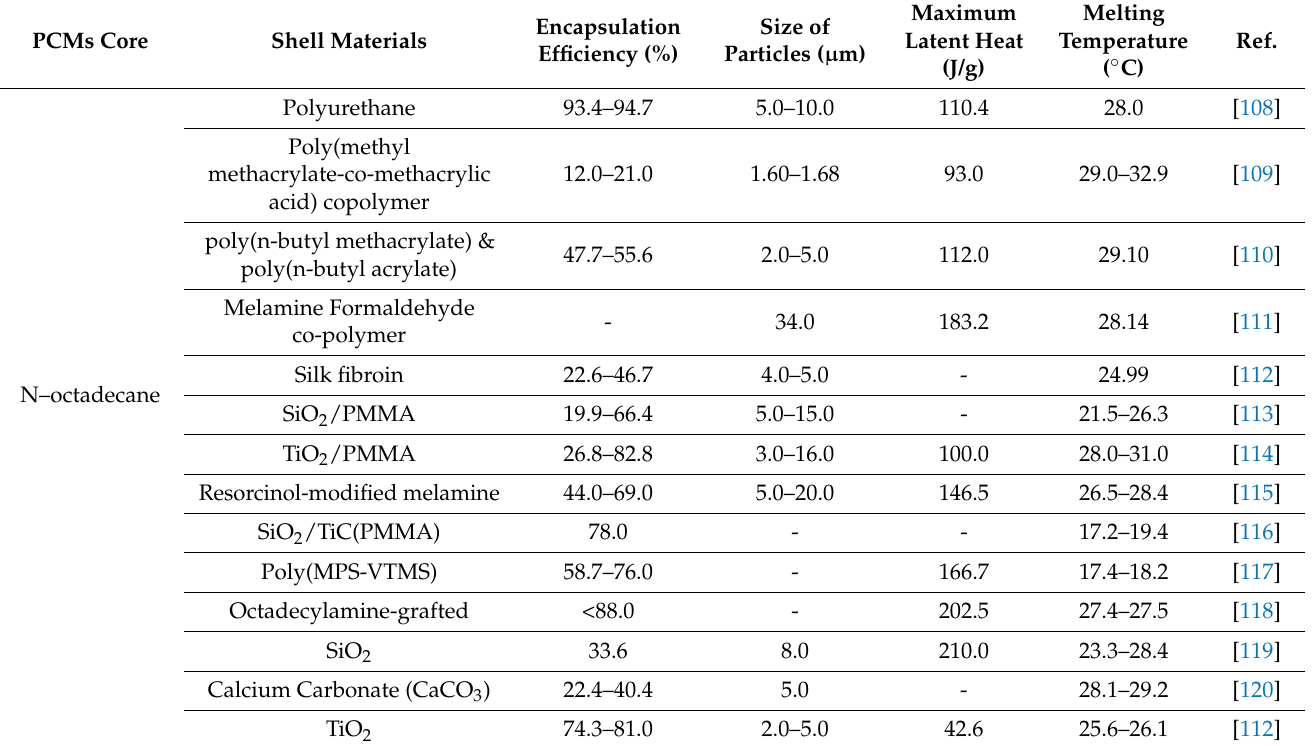
Figure 14. Macro-encapsulation of PCMs in ( a ) pouches and ( b ) flat panels [107]. A list of PCMs that are suitable for micro-/macro-encapsulation, with their respective thermo-physical properties appropriate for wall construction, is given in Table 6. Table 6. Thermo-physical properties of micro-/macro-encapsulations suitable for wall construction applications available in the literature.